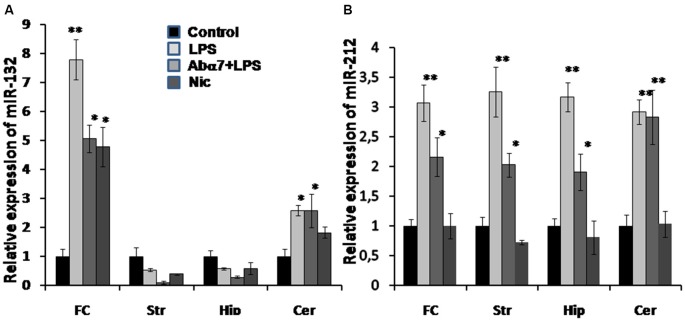
Transcript levels of miR-132 (A) and miR-212 (B) in various brain regions of mice treated with LPS, α7(1–208)-specific antibody + LPS or nicotine (3 days) compared to untreated mice. Designations are similar to those in Figures 1– 5. N = 5–8/group. *p < 0.05; **p < 0.005 compared to Control.